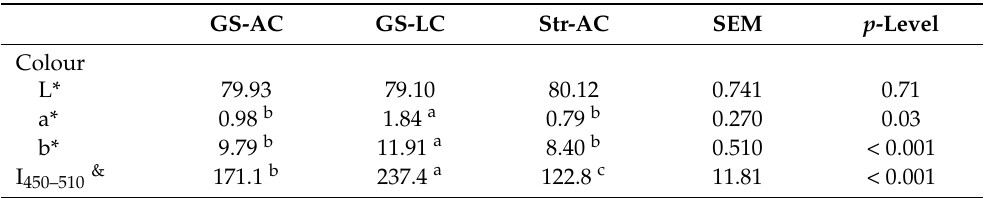
Table 6. Instrumental colour values and index in perirenal fat of young Tudanca bulls reared under different feeding